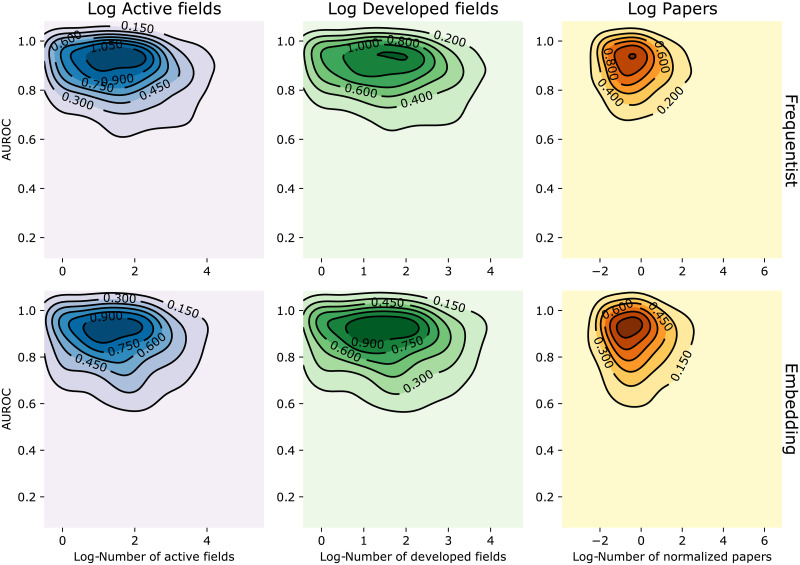
AUROC distribution for institutions vs. data properties.Empirical distributions of the AUROC as a function of the logarithms of the (i) number of active fields, (ii) number of developed fields and (iii) normalized number of papers. Time windows are set as in the first experimental setup. Contour plots were created from 500 sample points using Gaussian kernels.